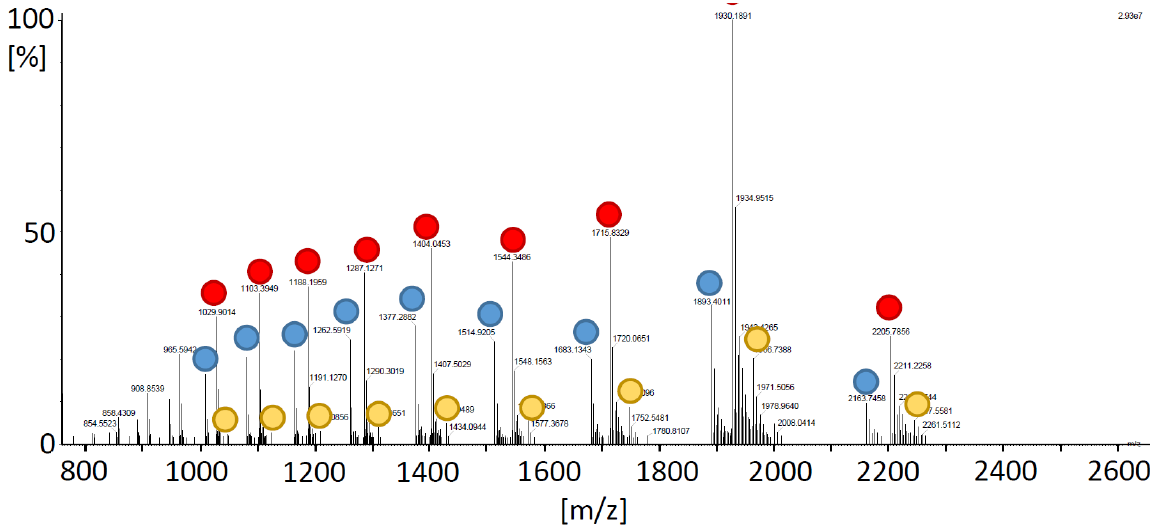
Figure 4. MS analysis of OPDAylated TRX-h3. TRX-h3 (20 µ M, in 50 mM NH4Ac) was incubated with 150 µ M OPDA overnight and applied to the mass spectrometer. The mass spectrum shows several charge states (z = 7 to 15) of the free TRX-h3 (mass of 15,139.12 ± 0.07 Da; blue dots), single OPDA-bound form with a mass of 15,433.43 ± 0.02 Da (red dots) and double OPDAylated form of 15725.80 ± 0.22 Da (yellow